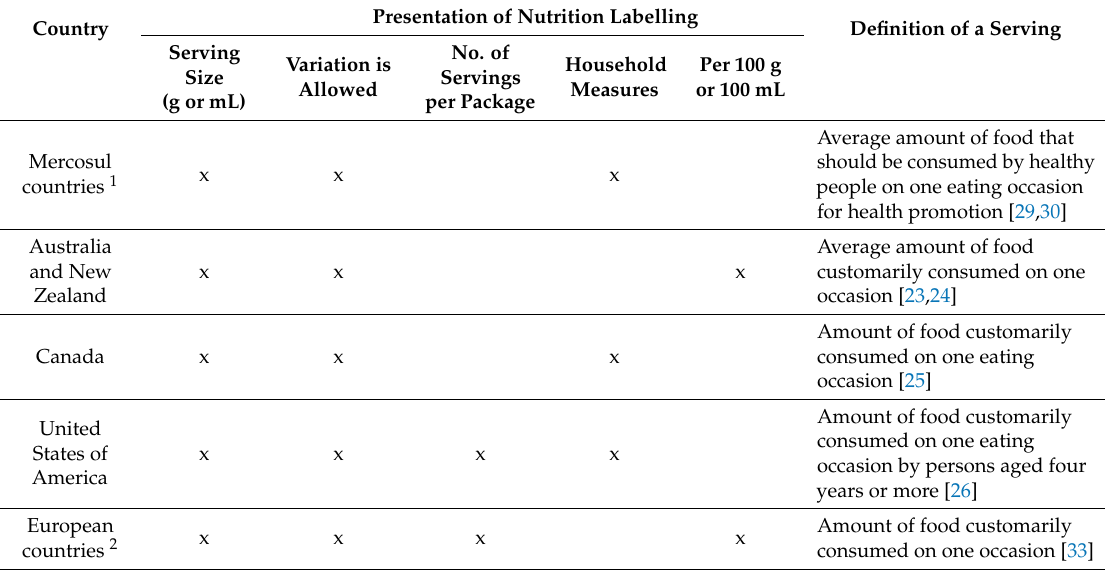
Table 1. Nutrition labelling and serving size definition in countries with mandatory nutrition